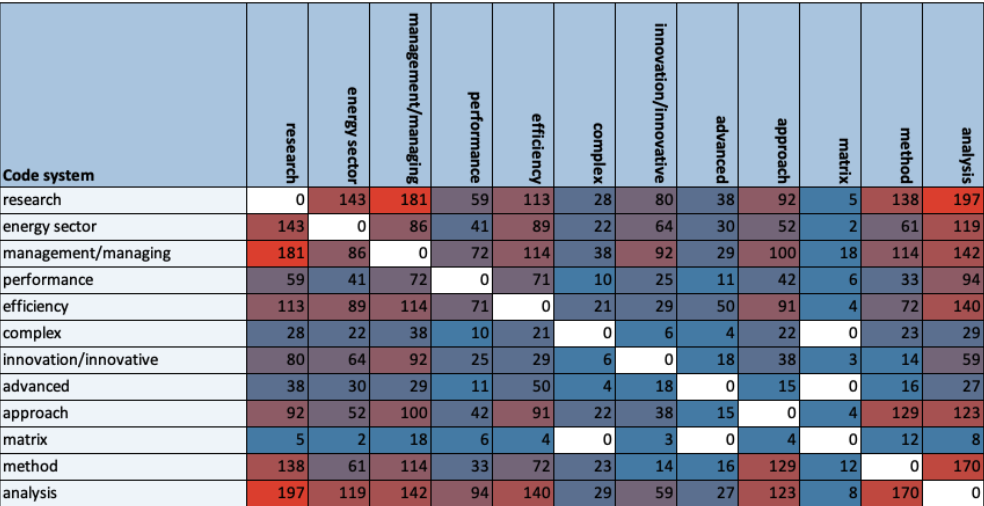
Figure 2. Code relations browser (the columns repeat rows, therefore the intersection of a row and column of the same code is always blank). Source: own study.